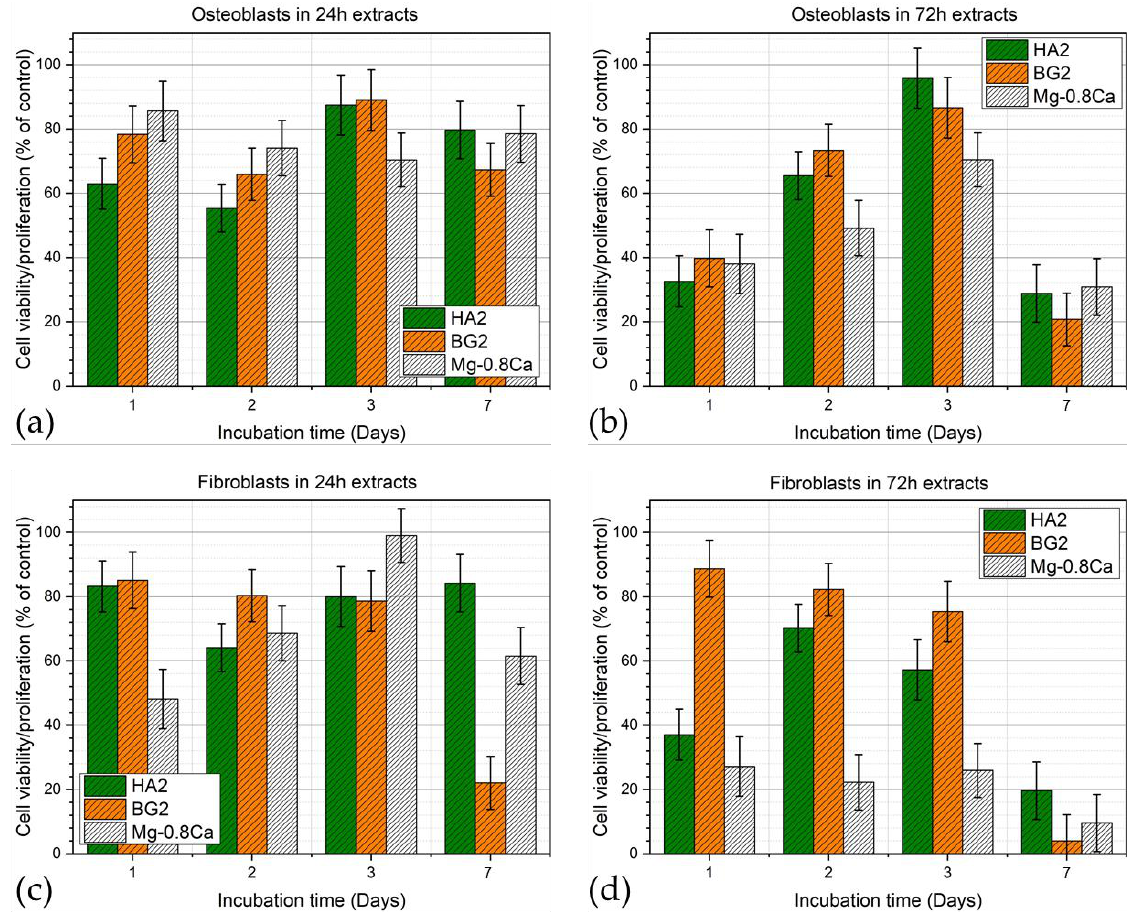
Figure 10. Viability/proliferation of ( a , b ) osteoblast and ( c , d ) fibroblast cells cultured for 1, 2, 3, and 7 days in ( a , c ) 24 h and ( b , d ) 72 h extracts obtained for the bare and HA2- and BG2-coated Mg-0.8Ca specimens.